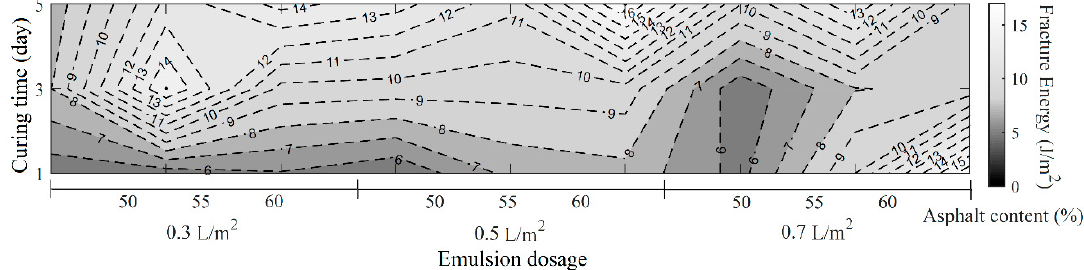
Figure 8. Fracture energy diagram of the slow setting asphalt emulsions for di ff erent dosages and cure times.